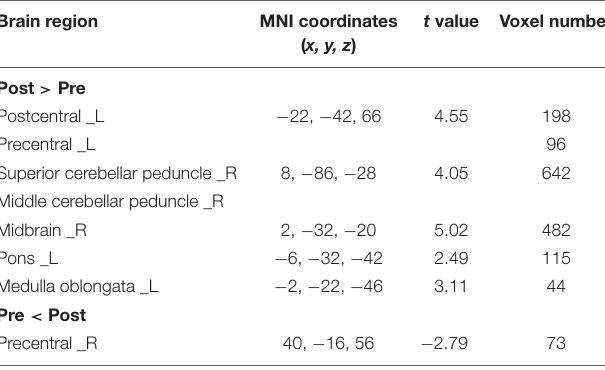
TABLE 2 | Brain regions showing significantly different CBF between pre- and post-rTMS treatment. Brain region MNI coordinates